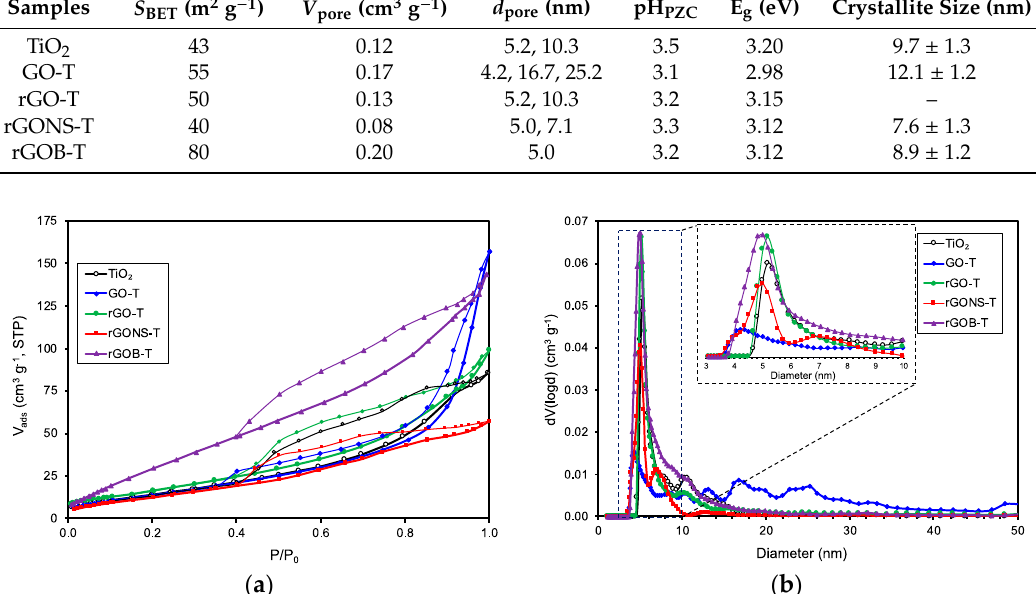
Table 1. Brunauer–Emmett–Teller (BET) surface area ( S BET ), total pore volume ( V pore ), mean pore diameter ( d pore ), pH at the point of zero charge (pH PZC ), band-gap energy (E g ), and crystallite size of synthetized materials.